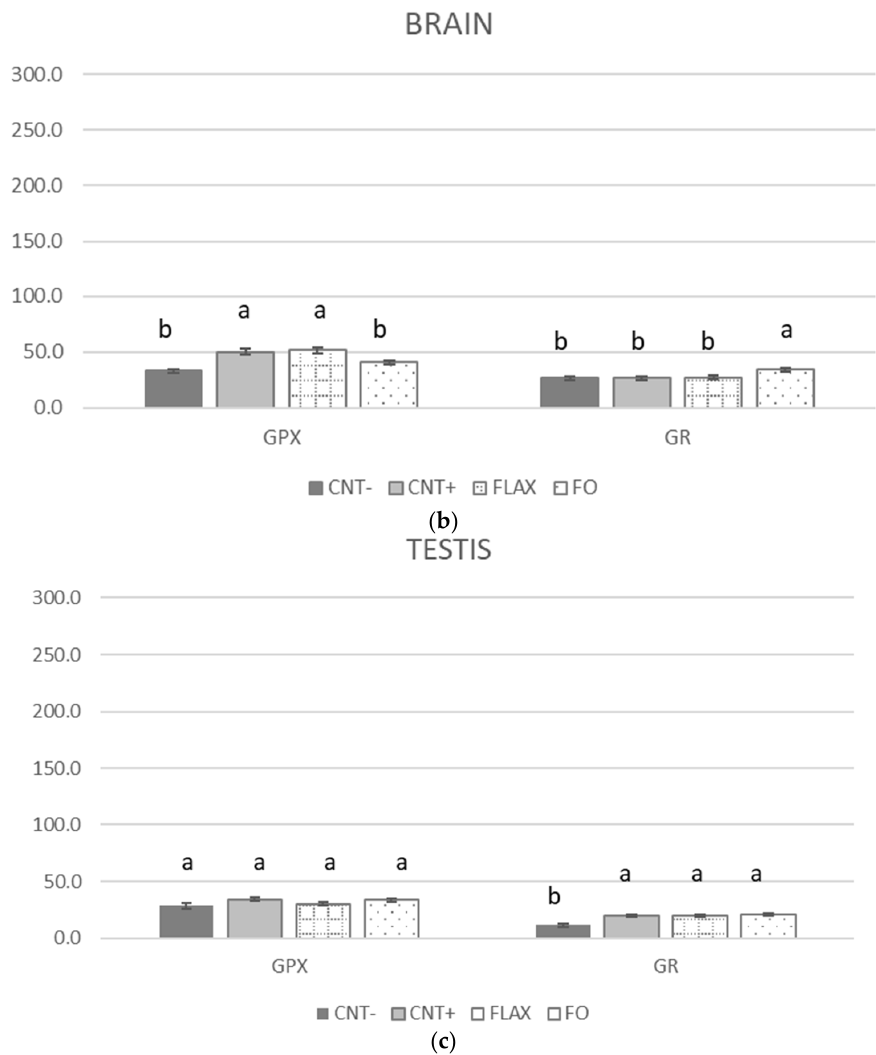
Figure 2. The effect of experimental diets on glutathione peroxidase (GPX) and glutathione reductase (GR) activites (U/mg protein) in rabbit ( a ) liver, ( b ) brain, and ( c ) testis. When values differences were too wide to show a complete graph, a support window was added to the main one. The bars represent least squares means + 95% upper and lower limits. The letters a–c indicate a significant difference between dietary groups ( p < 0.05, Bonferroni post hoc test).